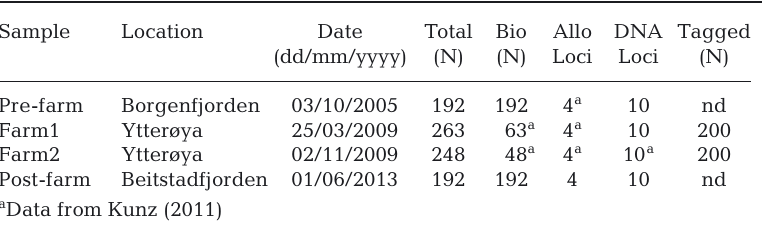
Table 1. Sampling and DNA marker information for Atlantic cod Gadus morhua , including sample name (locations of samples shown in Fig. 1A), and sampling date. Total (N): total number of individuals genotyped, Bio (N): individuals with full biological data and tissue samples, Allo Loci: number of allozyme marker loci, DNA Loci: number of DNA marker loci, Tagged (N): number of individuals used in tagging experiment (only fin clips and length information